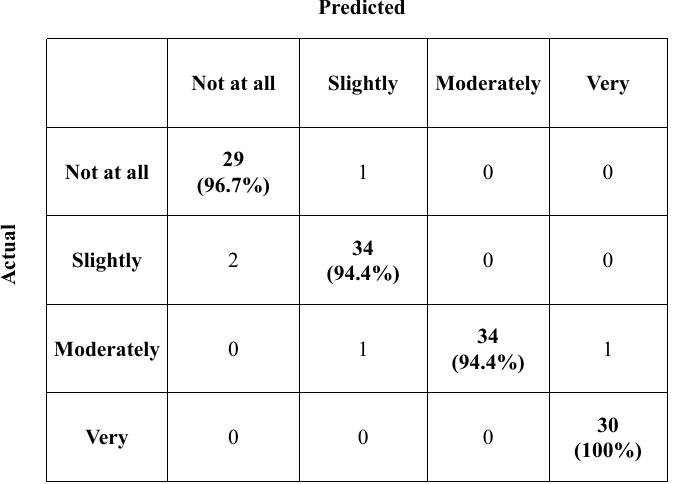
Figure 15. Training progress of the binaural MFCC-CNN model: ( a ) Training accuracy; ( b ) Training loss.